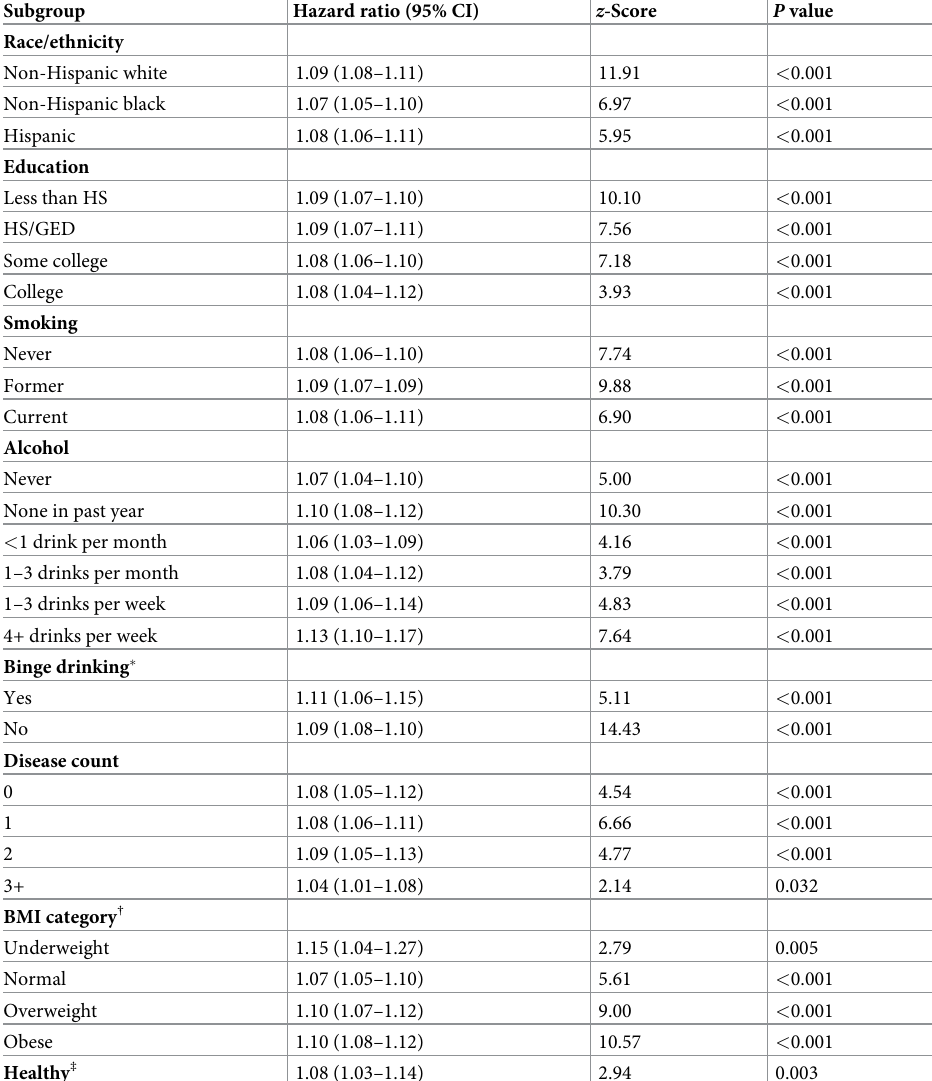
Results are based on parametric survival models (Gompertz distribution). All models were adjusted for chronological age and sex. � Binge drinking was defined at having 5+ alcoholic beverages at a time at least once per month. † Underweight was defined as BMI < 18.5 kg/m 2 , normal was defined as 18.5 � BMI < 25.0 kg/m 2 , overweight was defined as 25.0 � BMI < 30.0 kg/m 2 , and obese was defined as BMI � 30 kg/m 2 . ‡ Healthy participants were defined as those having no disease and normal